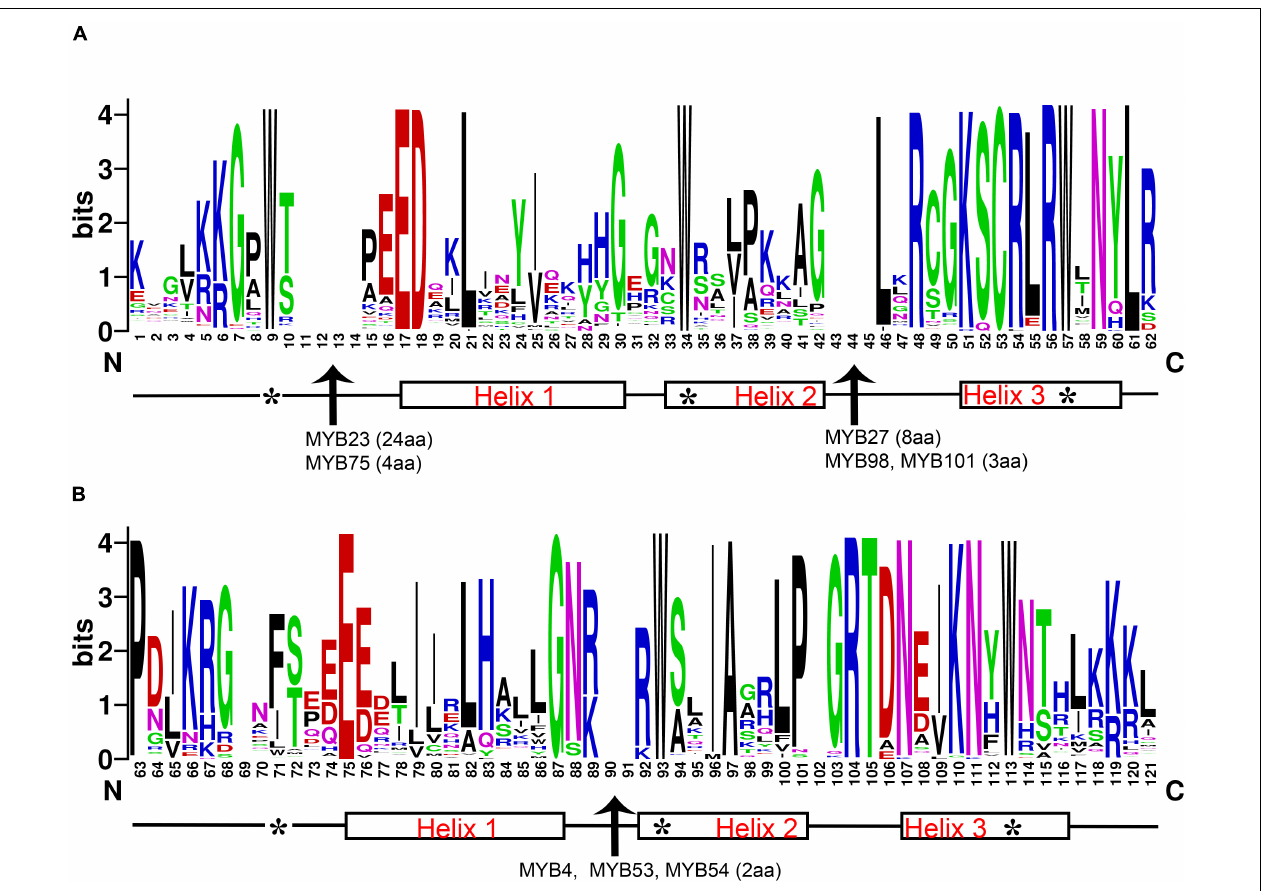
FIGURE 1 | Characterization of R2 (A) and R3 (B) MYB repeats of longan R2R3-MYB proteins. The position score indicated the degree of conservation of each amino acid at the specific position within sequences. The positions of the three α -helices are marked (helices 1–3). Arrows represent amino acid insertion sites detected in the R2 repeat of genes DlMYB23 , DlMYB27 , DlMYB75 , and DlMYB98 and the R3 repeat of DlMYB53 , DlMYB54 , and DlMYB93 . The length of each insertion (amino acid, aa) is highlighted in parentheses. Characteristic tryptophan (W) residues are marked with the symbol